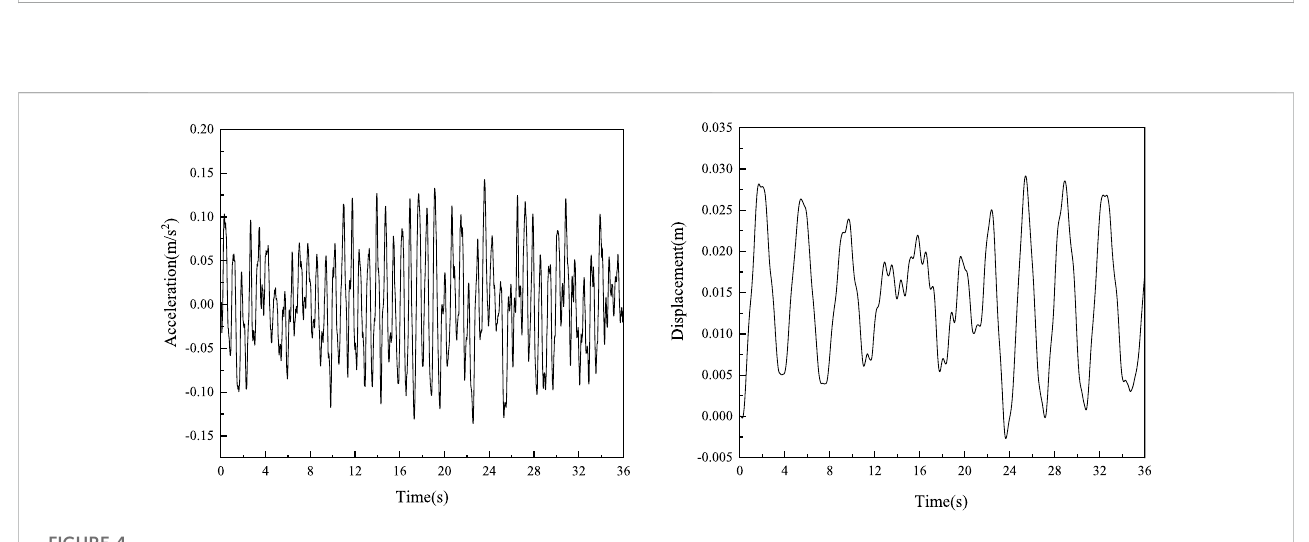
FIGURE 4 The acceleration and displacement response of wind turbine room under random ice force.